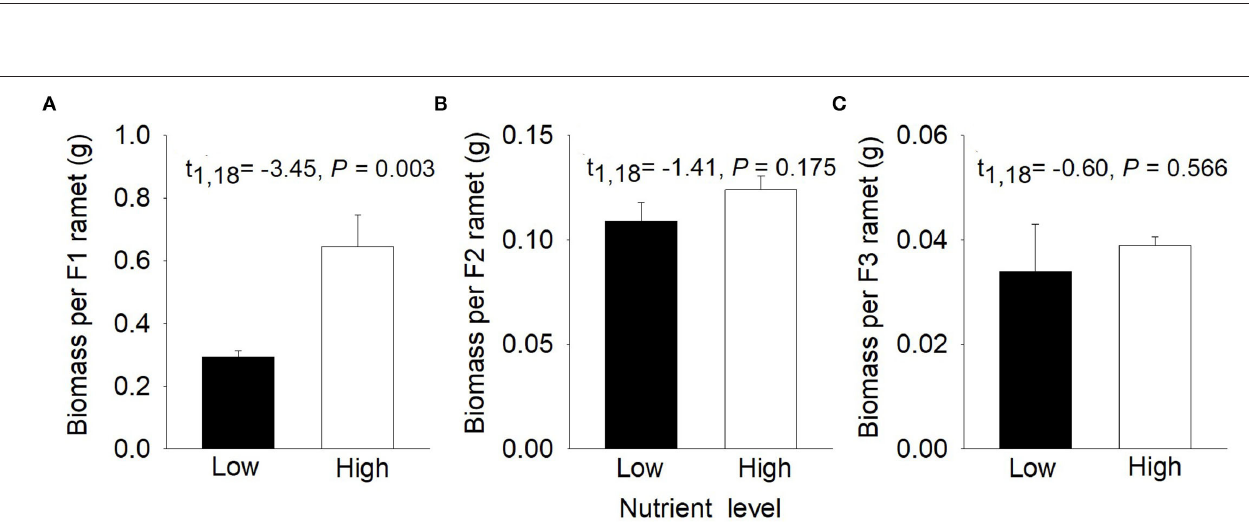
Frontiers in Plant Science |